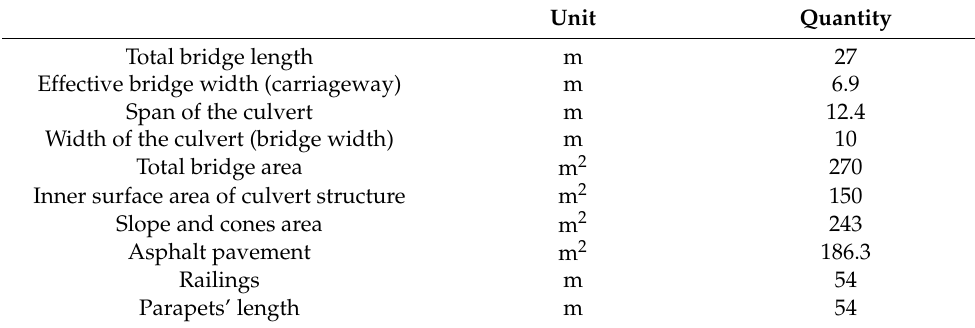
Table 4. Information regarding the steel culvert bridge.